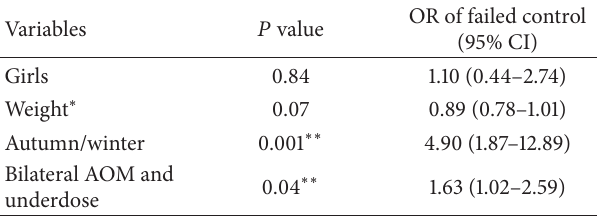
Table 4: Factors relevant to poor outcome of acute otitis